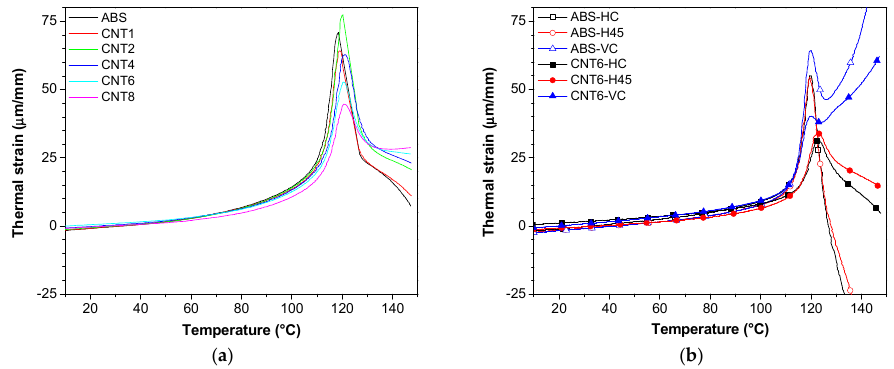
Figure 12. Thermal strain of neat ABS and nanocomposite samples as measured on filaments ( a ) and 3D-printed samples ( b ) along different orientations (HC, H45 and VC). Table 9. Coefficients of linear thermal expansion (CLTE) and linear thermal deformation (CLTD) of ABS and its nanocomposites as measured on filament and FDM samples (see Equation (4) for detail). Sample